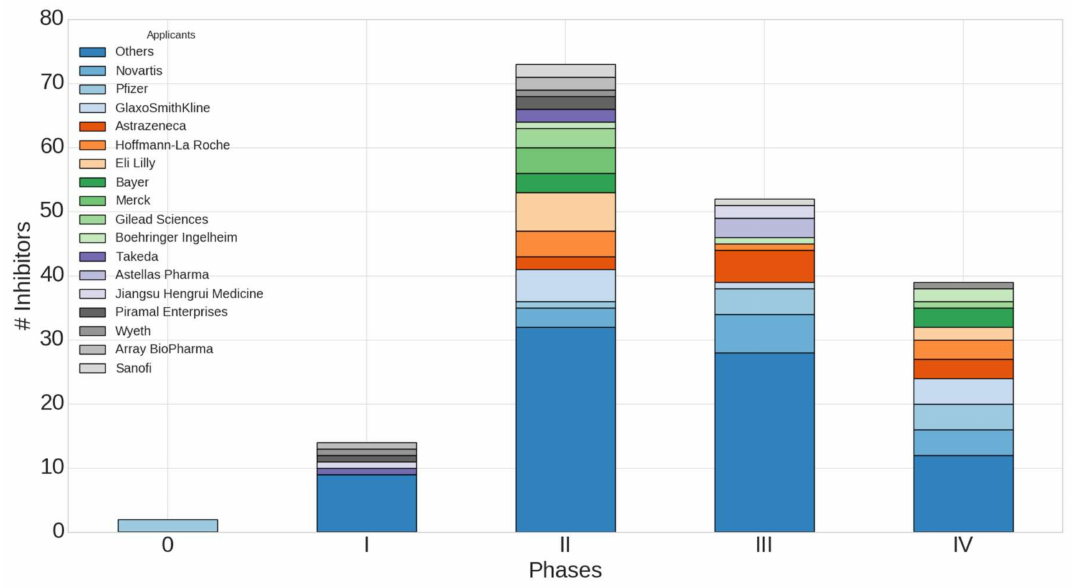
Figure 9. Protein kinase inhibitors having reached the highest phase of clinical trials grouped by pharmaceutical